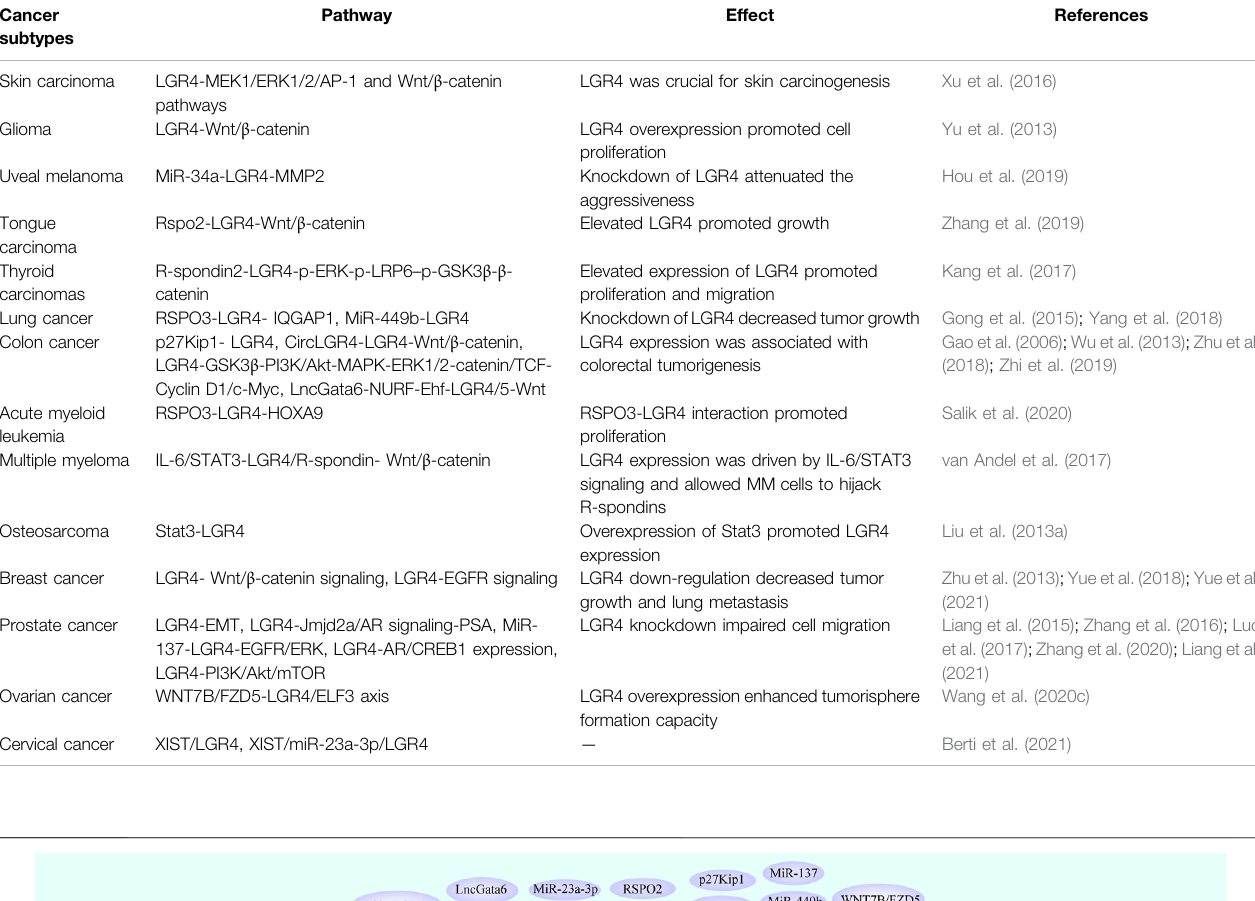
TABLE 5 | The gene of LGR4 involving in the process of multiple tumors.